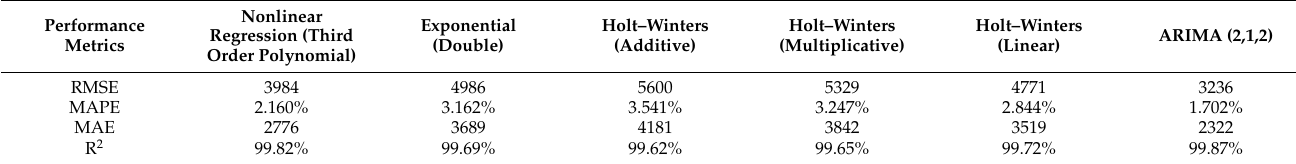
Table 1. Comparison of Forecasting